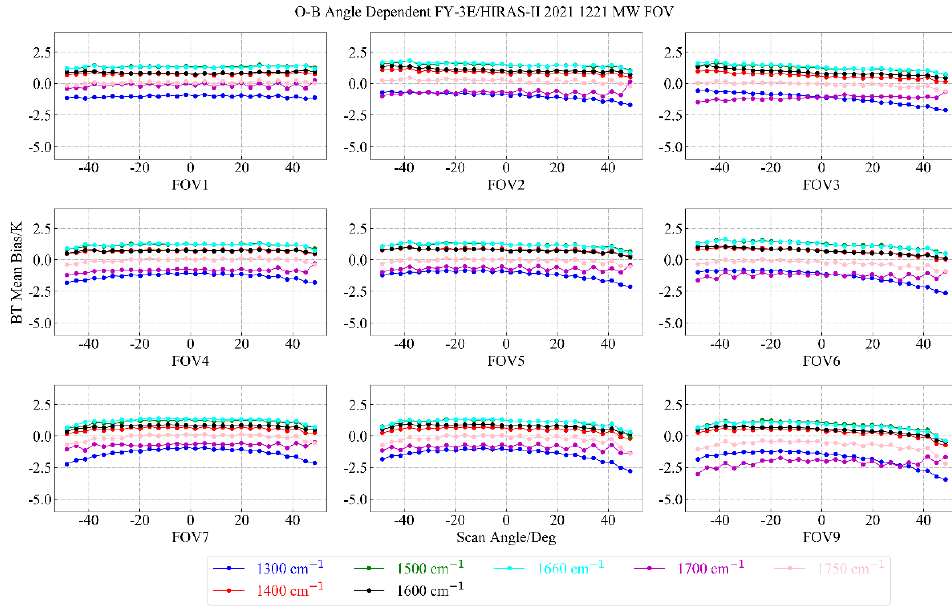
Figure 16. Distribution of mean bias of OMB values of 9 FOVs of typical medium-wave channels as a function of scanning angle.